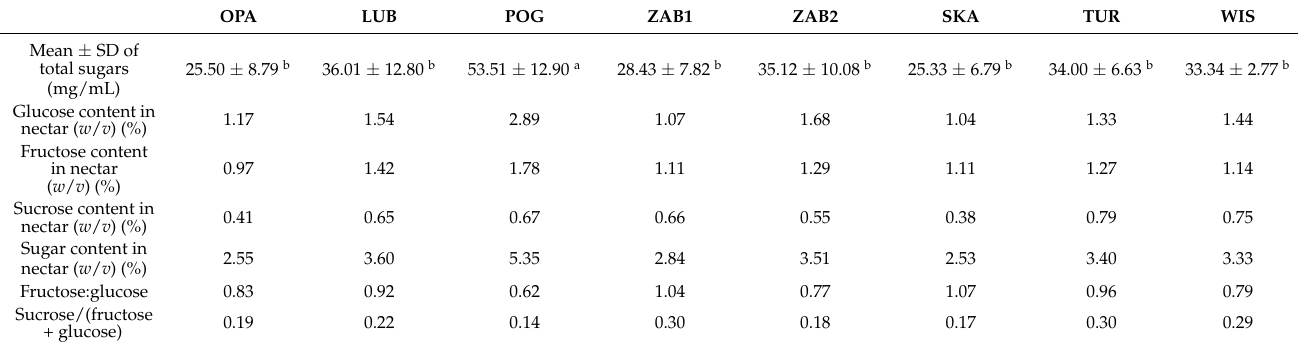
Table 4. The amount of sugars in Neottia ovata nectar. The same letters indicate statistically nonsignificant differences according to Tukey’s post-hoc